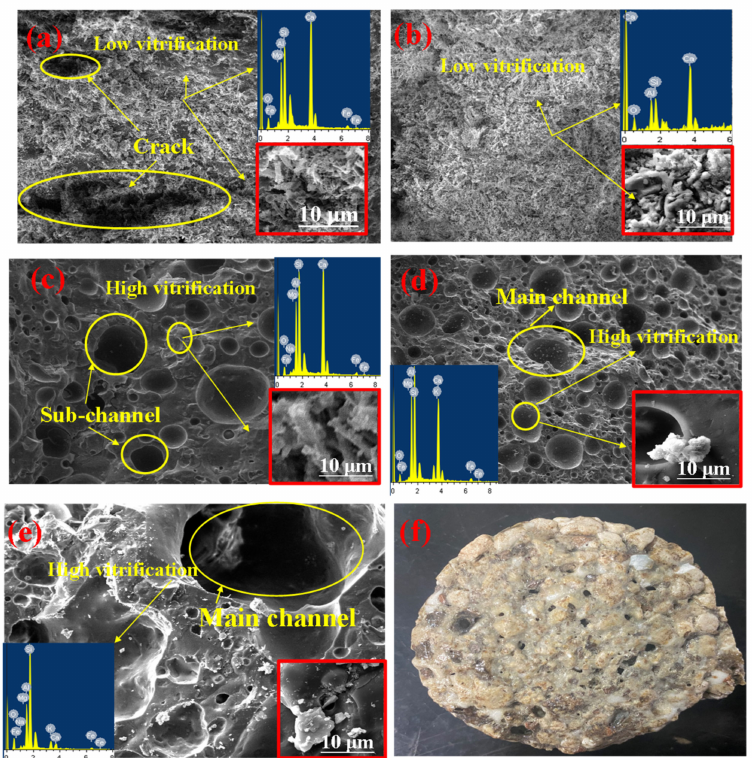
Figure 5. SEM photographs of samples at different temperatures: ( a ) 1125 ◦ C; ( b ) 1150 ◦ C; ( c ) 1175 ◦ C;